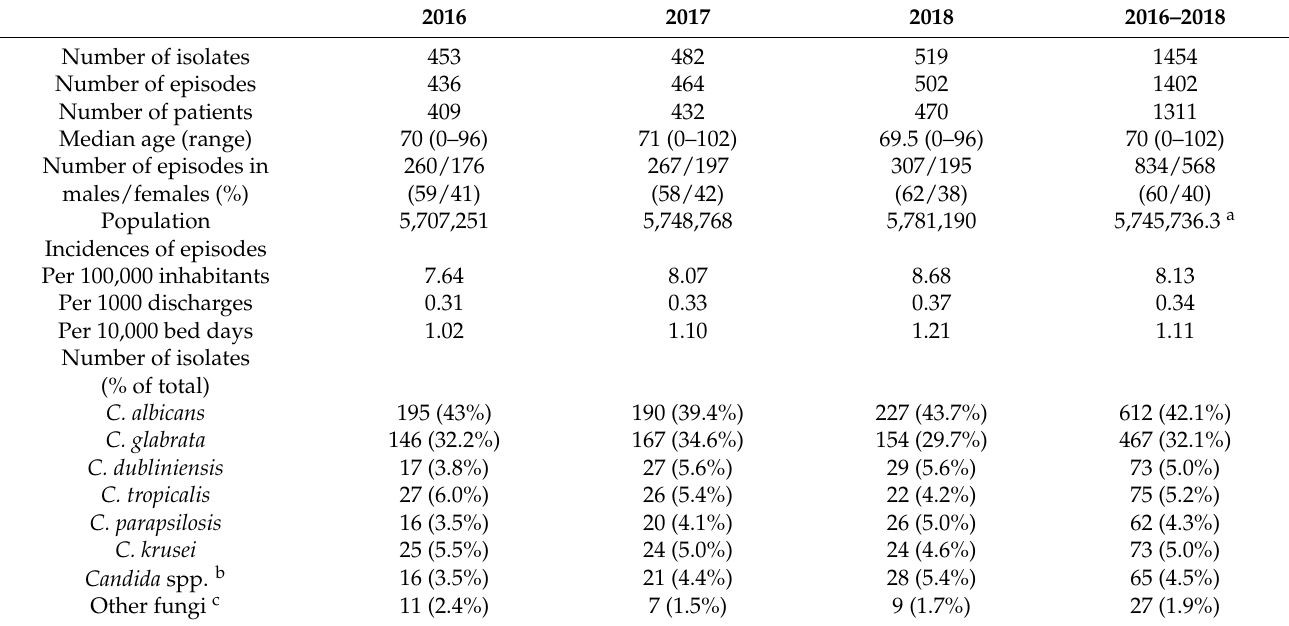
Table 1. Population and patient demographics, episode rates, and species distribution.